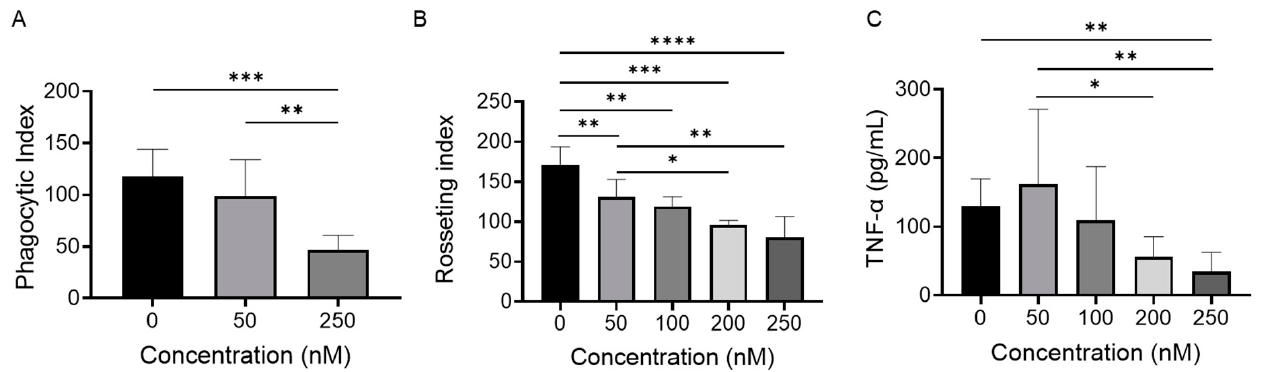
Figure 4. BET inhibition downregulates Fc γ R-mediated signaling. Healthy-donor CD14 + monocytes were treated with PLX51107 (250 nM) or vehicle control (DMSO) for 24 h and then subsequently activated with heat-aggregated IgG for 7 min. Whole cell lysates were obtained, and immunoblotting was done to detect activation of the ( A ) NK- κ B, ( B ) MEK1/2 and ( C ) PI3K pathways with phospho-specific antibodies. GAPDH was used as loading controls. Representative western blots are shown (n = 3).